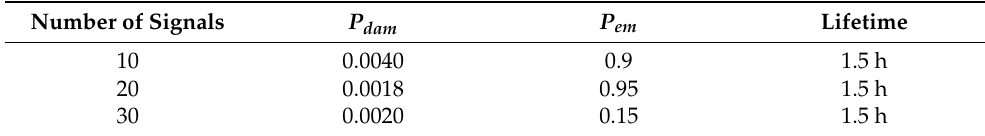
Table 1. Values of individual parameters for a different number of signals in the Chinese model [11]. Source of the experimental data: